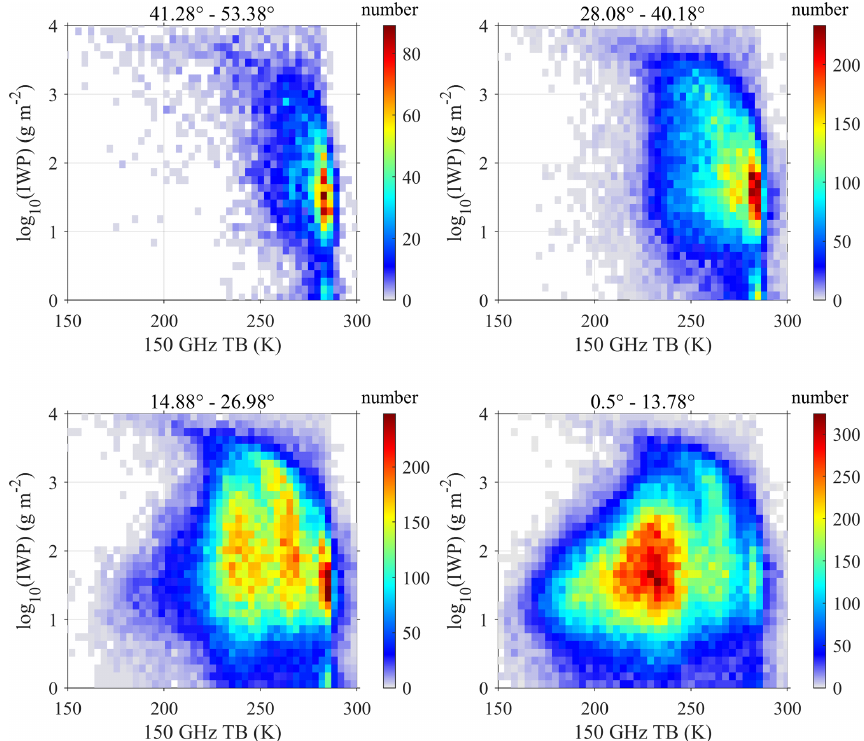
Figure 5. Statistical information of IWP and 150GHz (V) TB for different scan